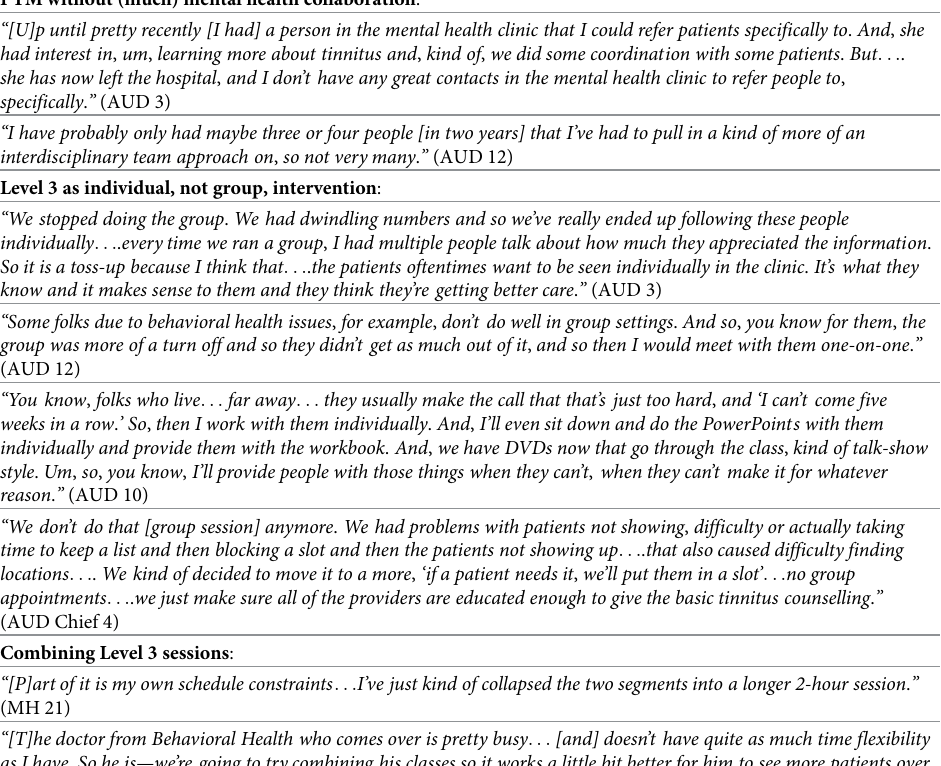
Table 2. PTM adaptations (illustrative